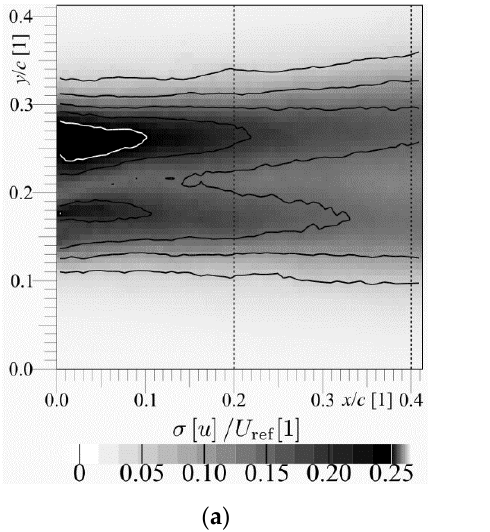
Figure 7. Standard deviation of stream-wise velocity. Panel ( a ) shows the map of σ ( u ) (grayscale) normalized by reference velocity. Panel ( b ) contains the standard deviation profiles at several distances from the trailing edge denoted as dashed lines in panel ( a ); we apologize to readers with grayscale printer.